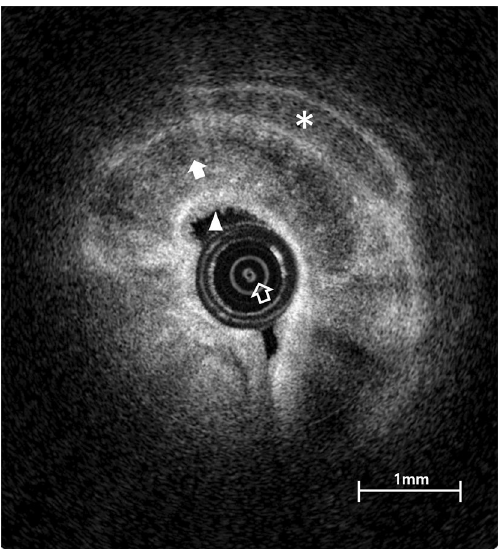
Figure 3. A representative optical coherence tomography image from near the isthmus portion of the left Eustachian tube, identifying cartilage (white filled arrow), mucosa (filled arrowhead), inner imaging catheter (empty arrow), and fat layer (asterisk).